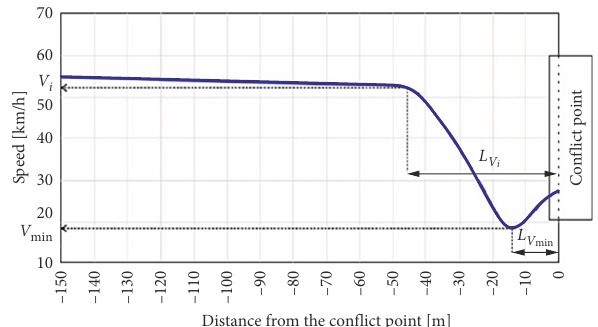
Distance from the conflict point Figure 2. Dependent variables descriptive of the driver’s behaviour while approaching the conflict point with pedestrian crossing